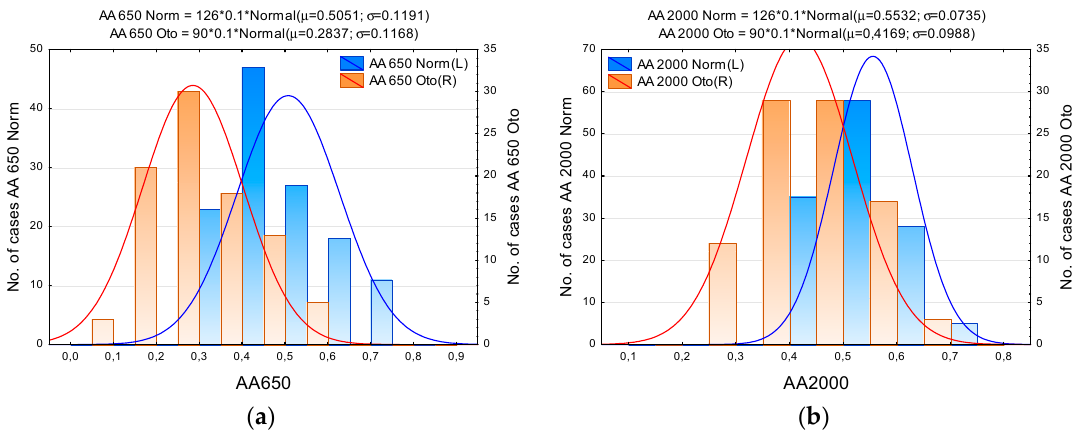
Figure 8. Distributions of average absorbance over the 545–749 Hz (AA650) and 226–2000 Hz (AA2000) bands in the Normal and Otosclerotic groups. ( a ) Histogram of absorbance AA650; ( b ) Histogram of absorbance AA2000. Key: AA650 Norm, AA650 Oto, AA2000 Norm, AA2000 Oto—Absorbance in Normal and Otosclerotic subjects, respectively. Bars represent number of cases in consecutive intervals. The lines show fitted normal distributions.